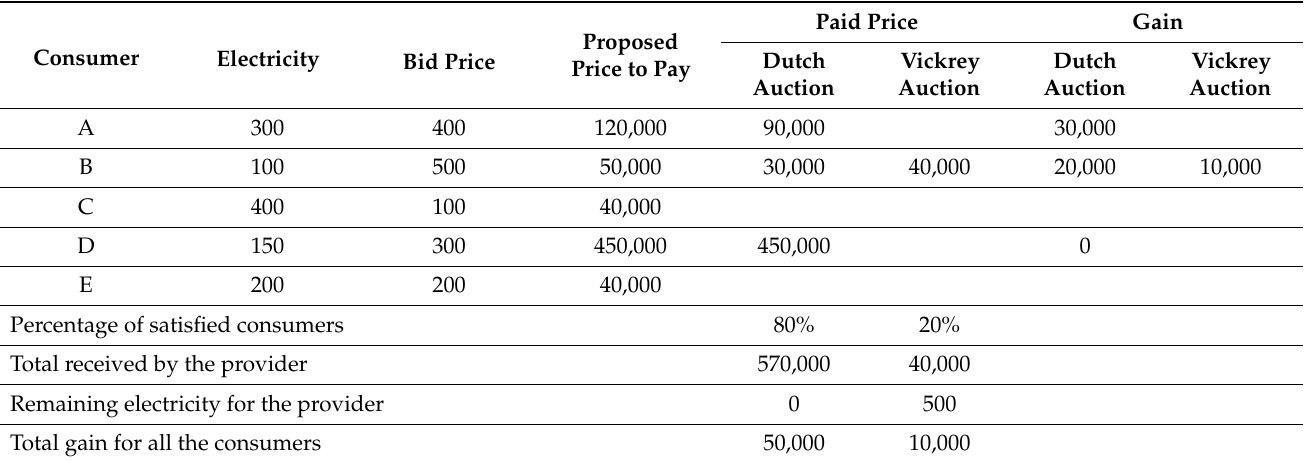
Table 6. Running example to compare Vickey and Dutch auctions based on